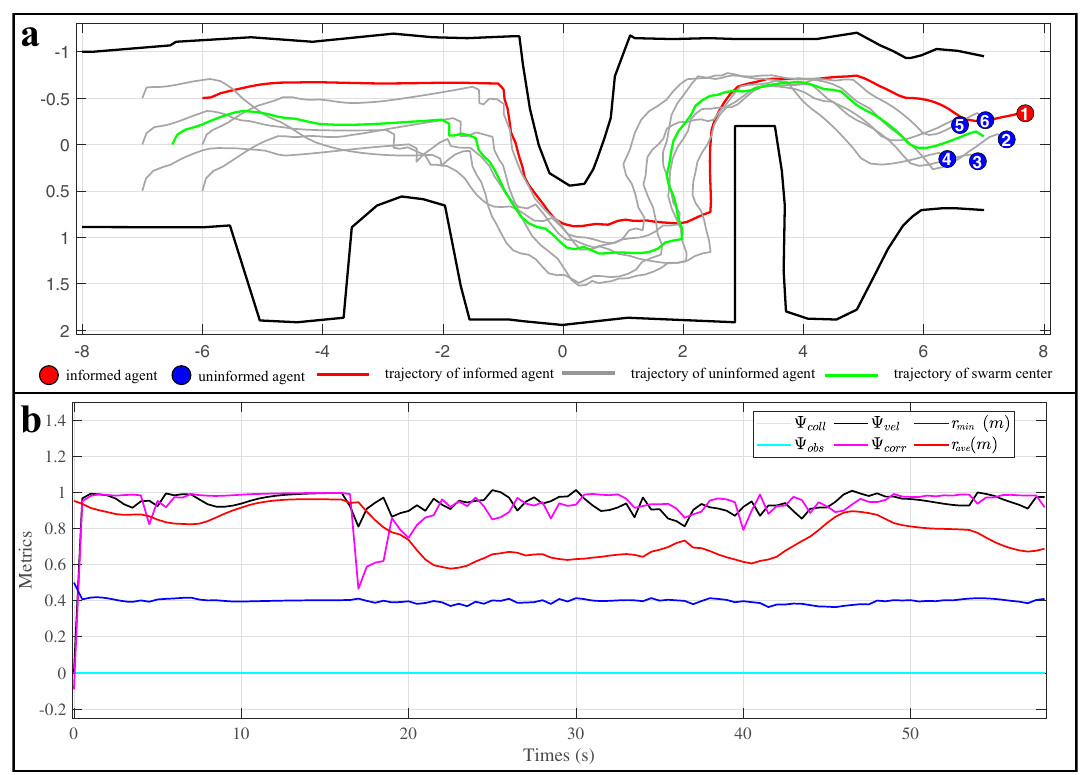
Fig. 13 Simulation of the flocking algorithm with AGDS in a complex irregular environment. a The flight trajectories of the drone swarm when traversing the complex and irregular environment. b The evaluation metrics of the flocking algorithm with AGDS Table 1 Aggregate performance of the informed agent at different initial positions in the canyon-like environment